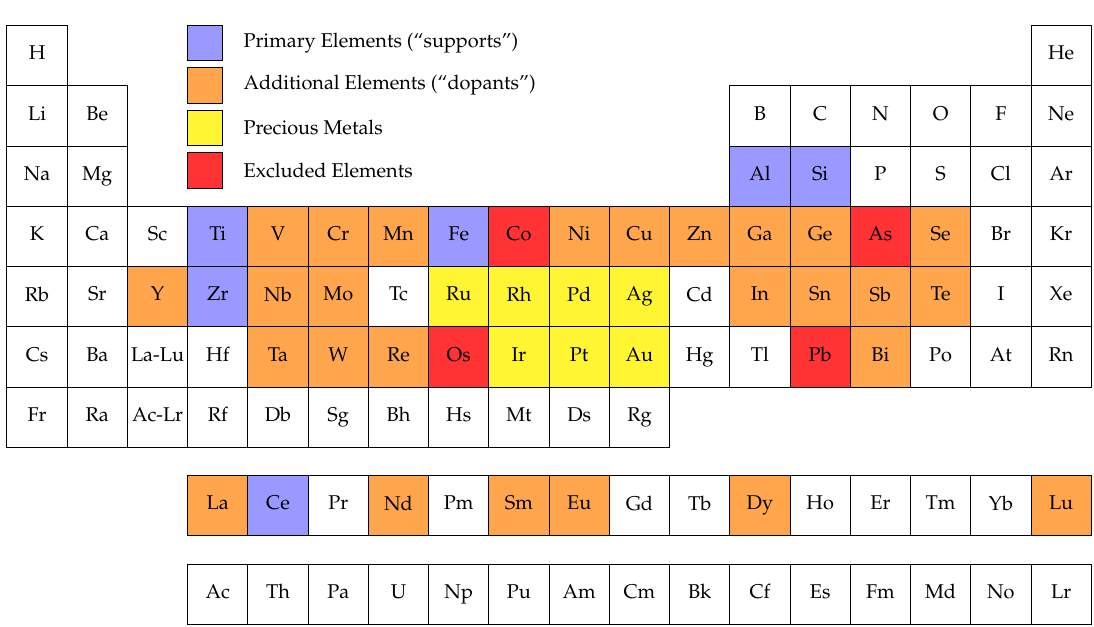
Figure 2. Design of Experiment. Highlighted primary elements (blue) have been combined with additional elements (orange) and PMs (yellow). In this paper, we report only on a selected subset of all possible combinations